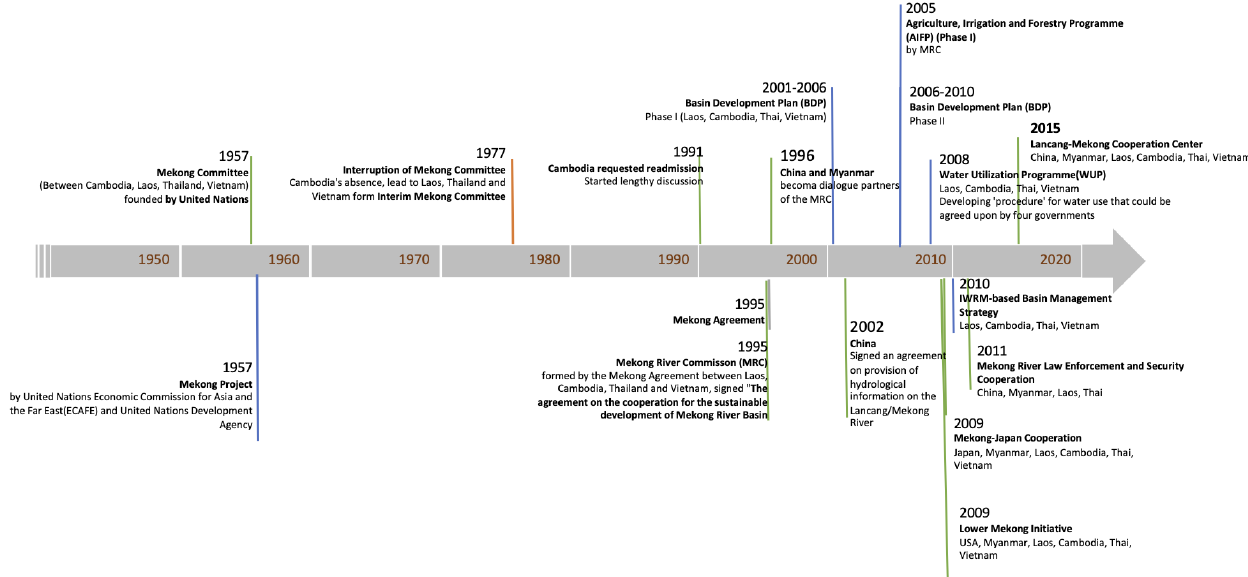
Figure 2. History of major events within the Lancang–Mekong River